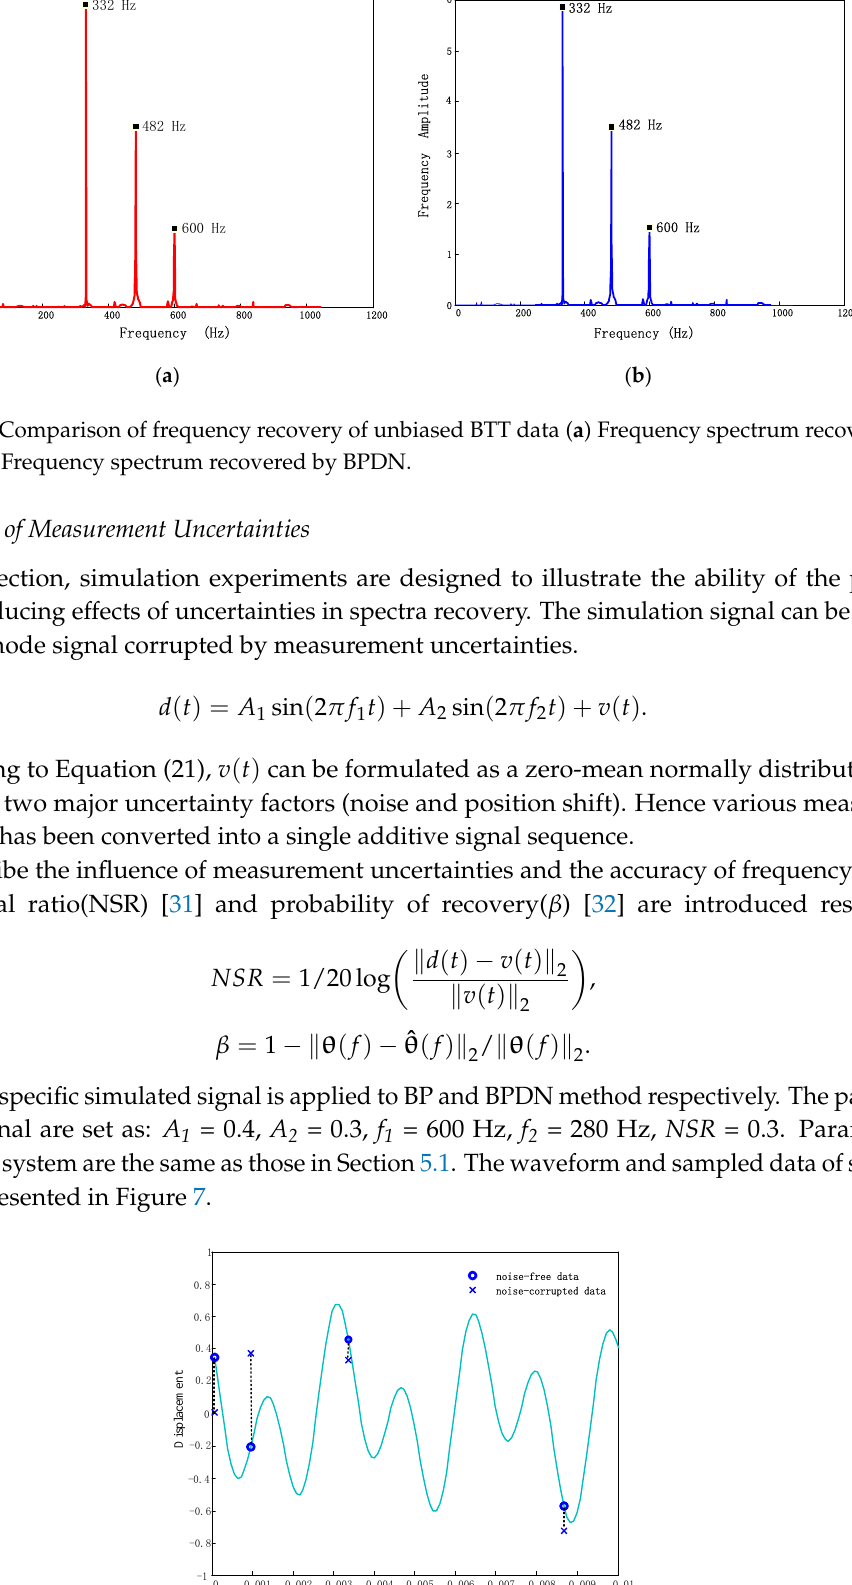
( b ) Figure 8. Comparison of frequency recovery of biased BTT data ( a ) Frequency spectrum recovered by BP( β = 31.29%, 𝑨 𝟏 𝑨 𝟐 ≈ 2:1 ) ( b ) Frequency spectrum recovered by BPDN( β = 56.03%, 𝑨 𝟏 𝑨 𝟐 ≈ 4:3 ). Then, comparison of both methods was performed using Monte Carlo simulations. The parameters of simulated signals are set as follows: amplitudes A 1 and A 2 are selected randomly in each test from the range (0, 1]. While the frequency f 1 and f 2 are selected randomly from (100, 1000] Hz. A number of probes ranging from three to five are used for sampling and recovering vibration signal. For each probe number, a set of angular position of probes which satisfies the minimal μ ( Q ) are selected and fixed during the simulation experiment. Six NSR values are selected from 0.05 to 0.3. The noises in different level will be added to original signals in test. 100 signals are generated under